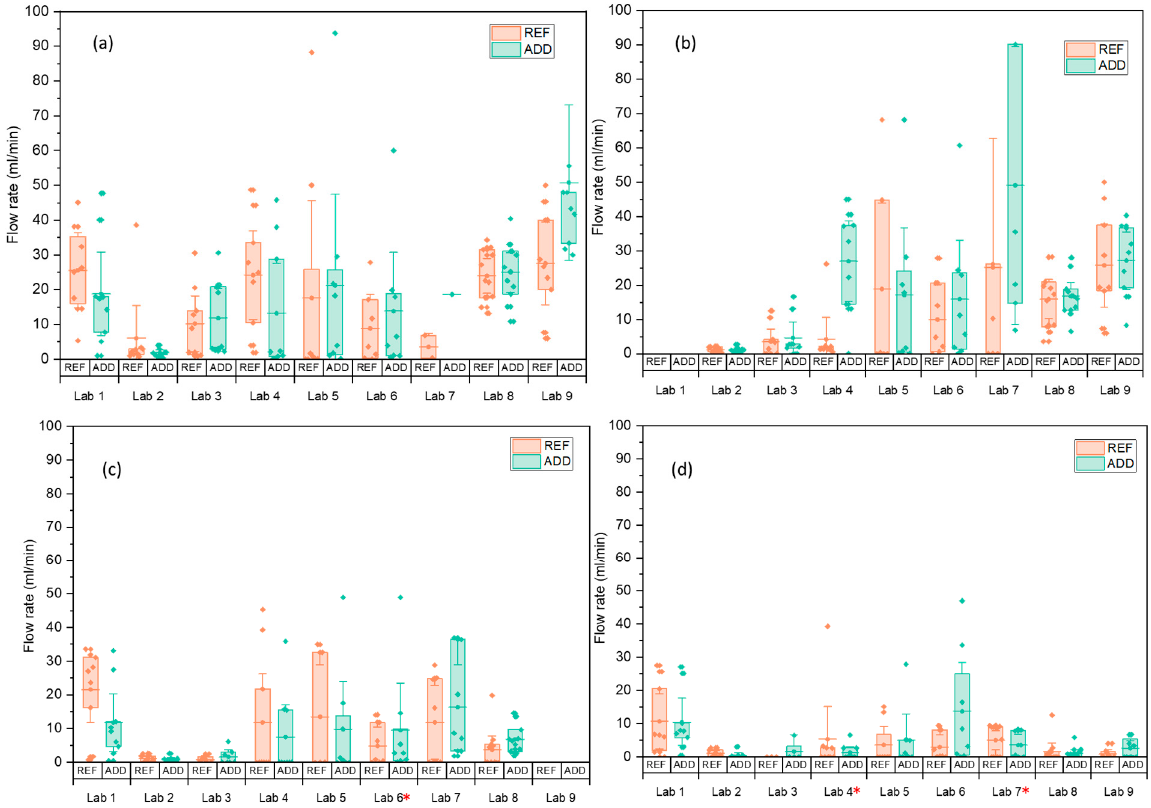
Figure 14. Individual flow rates q and the means of the different series indicated by horizontal lines (error bars give the 95% confidence interval on the mean); ( a ) at time 0, and after ( b ) 1 month, ( c ) 3 months, and ( d ) 6 months of healing. * denotes a longer healing period adopted. Table 9. Mean and coefficient of variation CV for the measured crack width w and water flow rate for both REF and ADD specimens of the nine labs at time